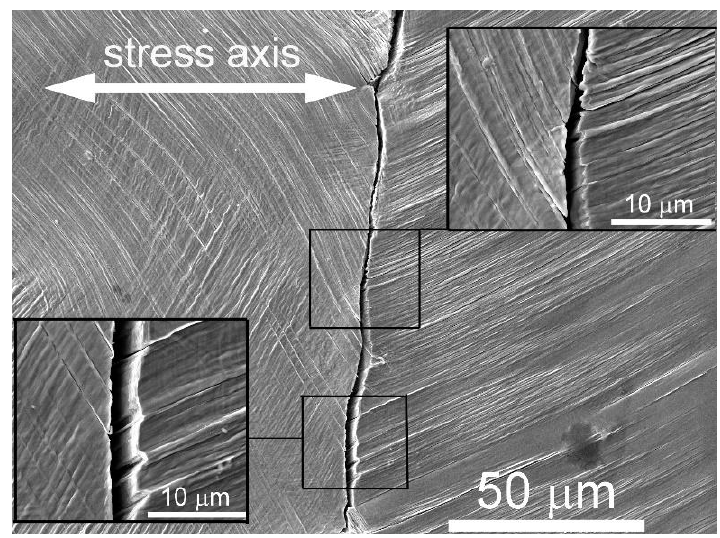
Figure 18. Surface of polycrystalline copper cycled with ε H = 4 × 10 −3 to fracture ( N f = 5600 cycles); details of a cracked grain boundary reveal PSMs from neighbor grains impinging the grain boundary and eventually leading to grain boundary crack initiation.